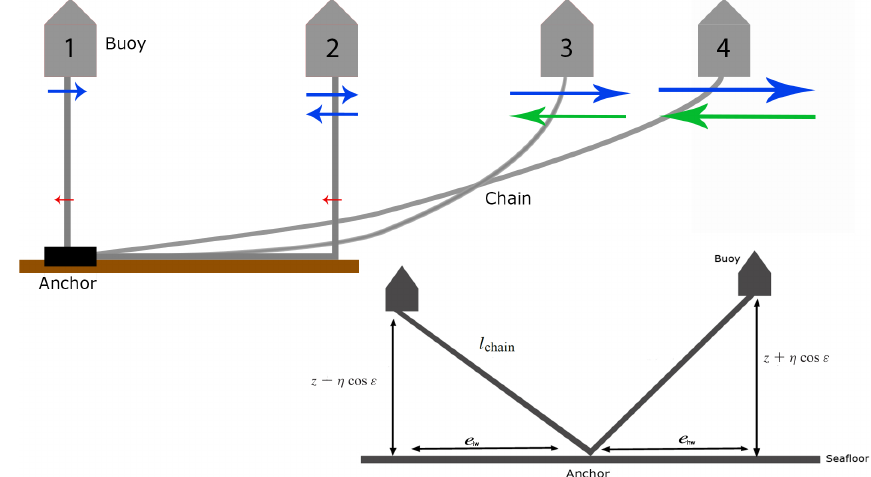
Figure 4. Schematic representation of the maximum extension e during high water (HW) and low water (LW); l chain indicates the length of the anchor chain, z denotes the depth with regard to the chart datum and η cos (cid:15) denotes the tidal elevation related to the chart datum. The buoy is shown in four critical positions. Blue arrows indicate the force created by the friction of the current on the buoy; this is the drag force. Red arrows indicate a drag force between the chain and the sea floor. Green arrows indicate an active spring force, created by the chain. The two blue arrows in position 2 indicate that during this position the current is changing its direction. Position 2 is the extension related to the moment of slack tide.